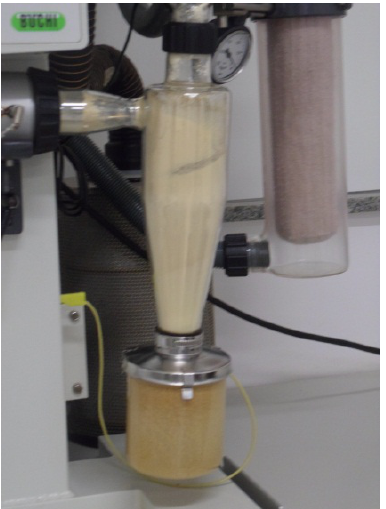
Figure 2. Adhesion of the product in the solid-gas separator and collection system of the Flawil,